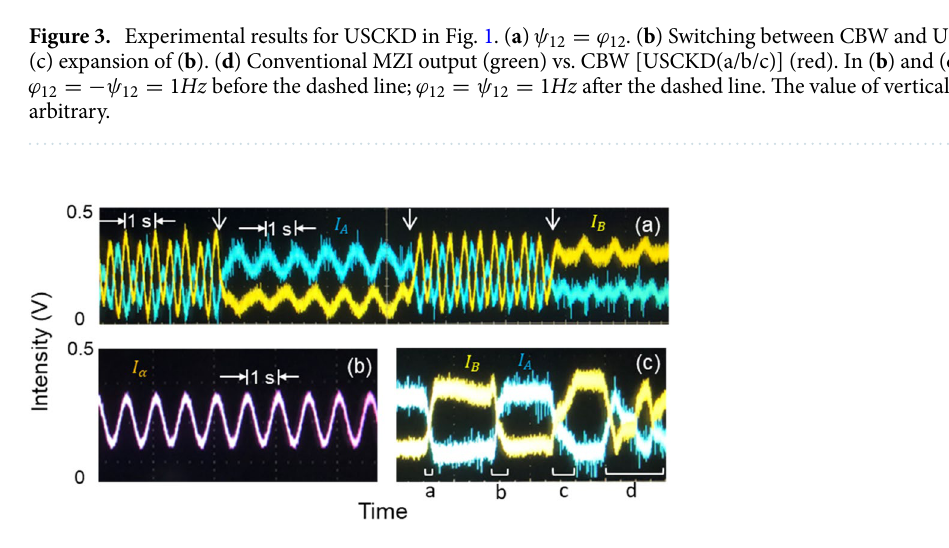
Figure 4. ( a ) CBW vs. USCKD. ( b ) Conventional MZI output I α . ( c ) Manual phase control for ψ 1 in Fig. 1. The driving frequencies for AOM B1 and B2 are 80,000,001 Hz and 80,000,000 Hz. The brackets in ( c ) indicate manual phase ( ψ ) scanning. Intensities in ( a – c ) are